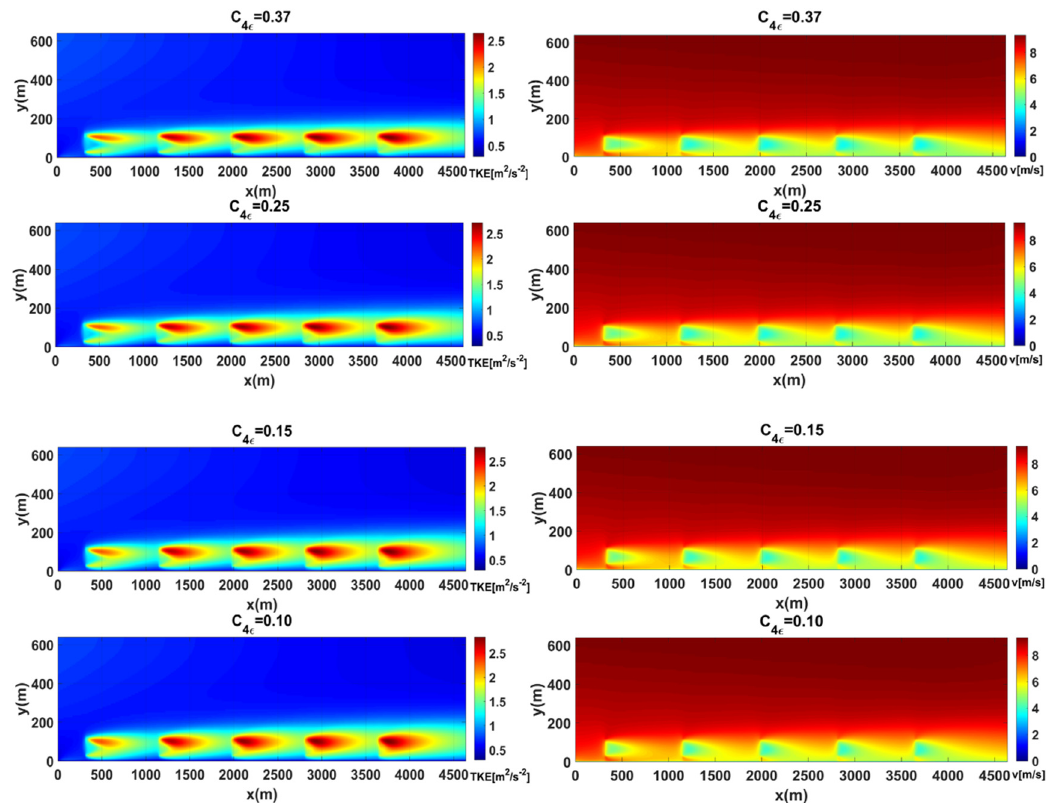
Figure 14. Comparison of contours involving TKE and streamwise wind speed for different C 4 ε in the vertical direction when the incoming wind direction is 312°.